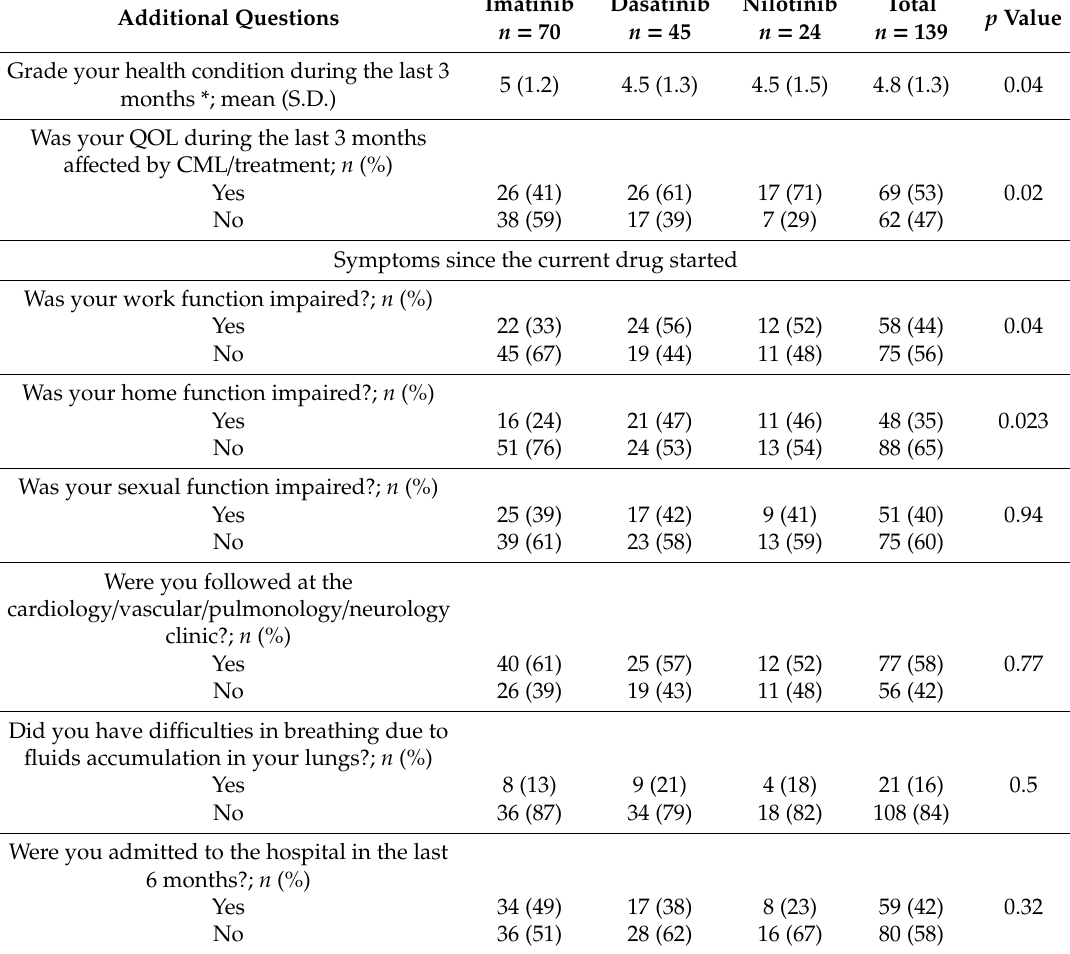
Table 3. Patients’ reported outcomes—additional